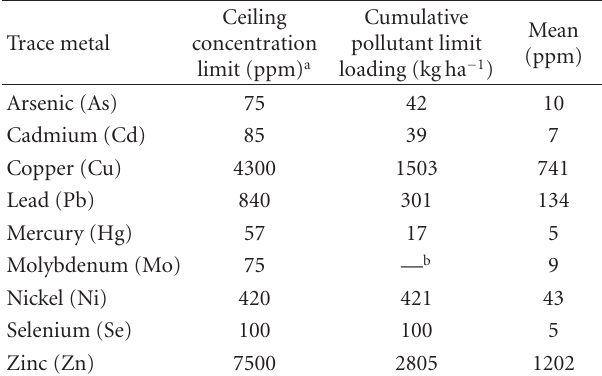
Table 1: Pollutant ceiling concentrations and cumulative loading amounts for biosolids (adapted from [6]) and mean concentrations measured in biosolids from the National Sewage Sludge Survey